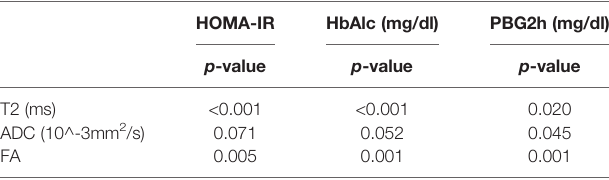
TABLE 4 | Correlation between muscle magnetic resonance parameters and type 2 diabetes markers (N = 24).